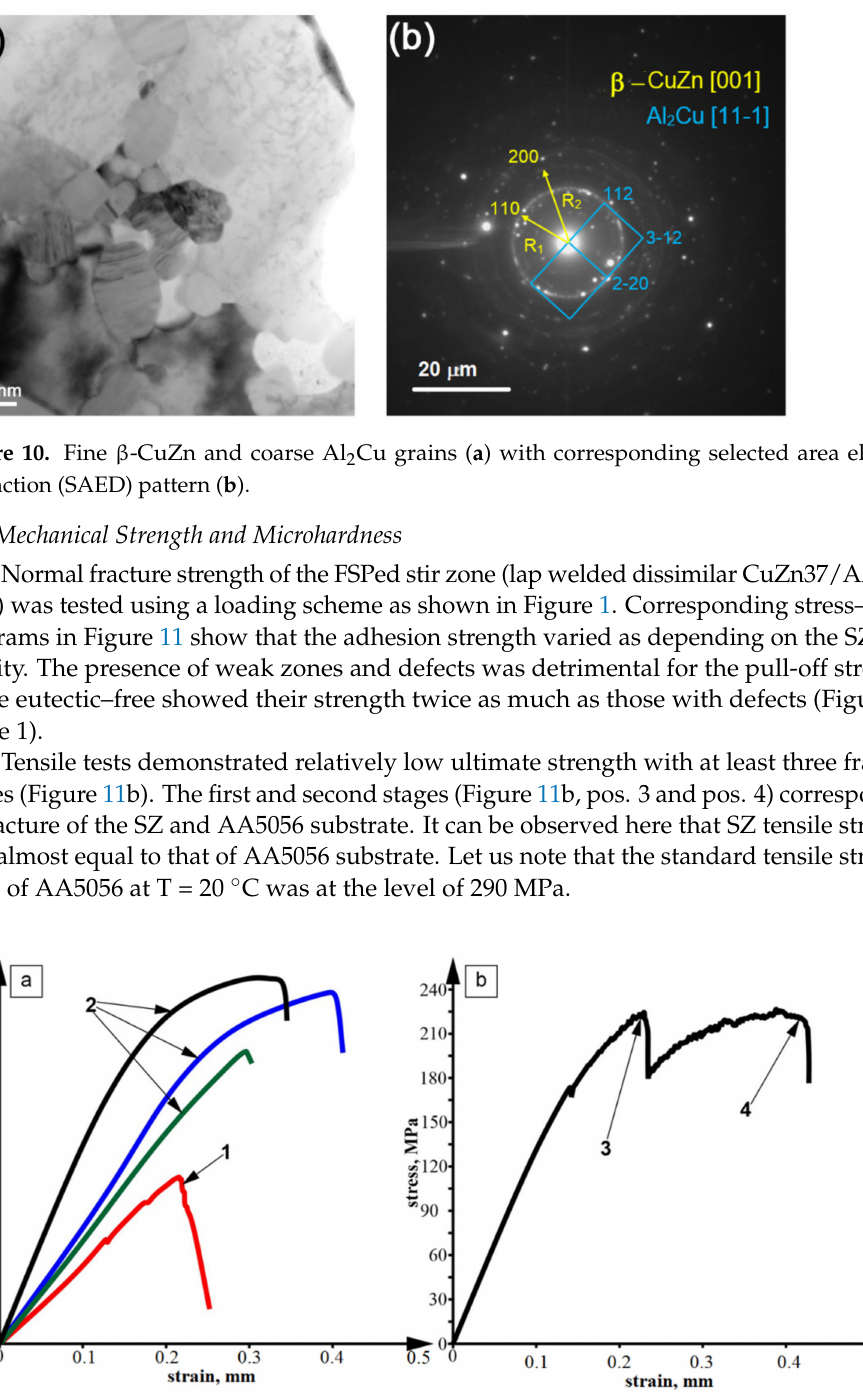
Figure 11. Adhesion ( a ) and tensile ( b ) stress–strain diagrams obtained on the dissimilar lap joints. 1—poor adhesion samples, 2—good adhesion samples, 3—SZ tensile fracture event, 4—substrate fracture